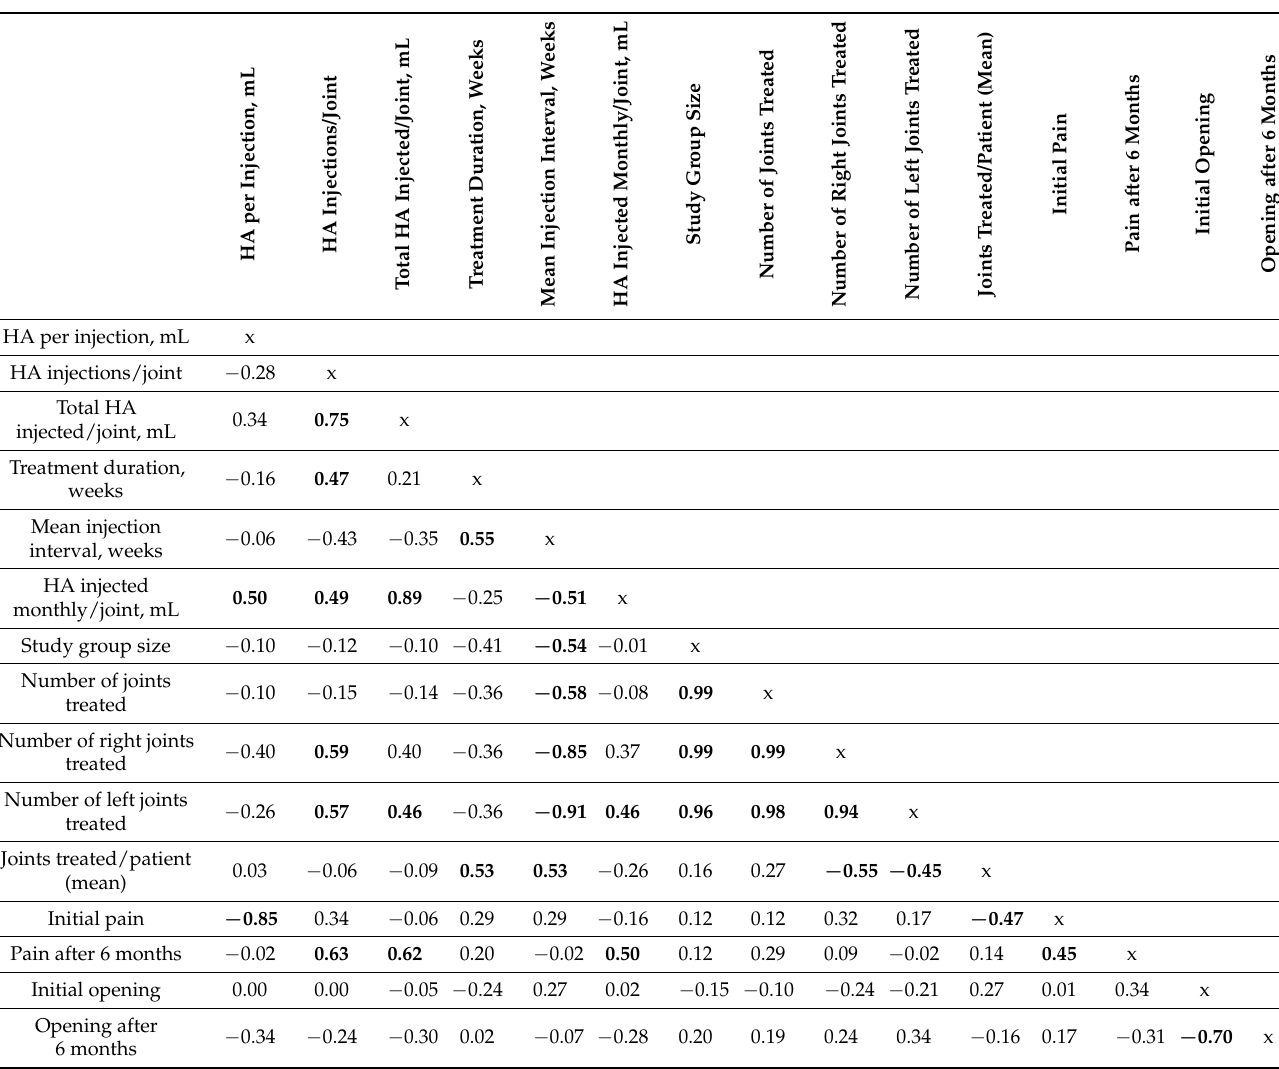
Table 8. Correlation matrix. Statistically significant results are shown in bold. Description in the